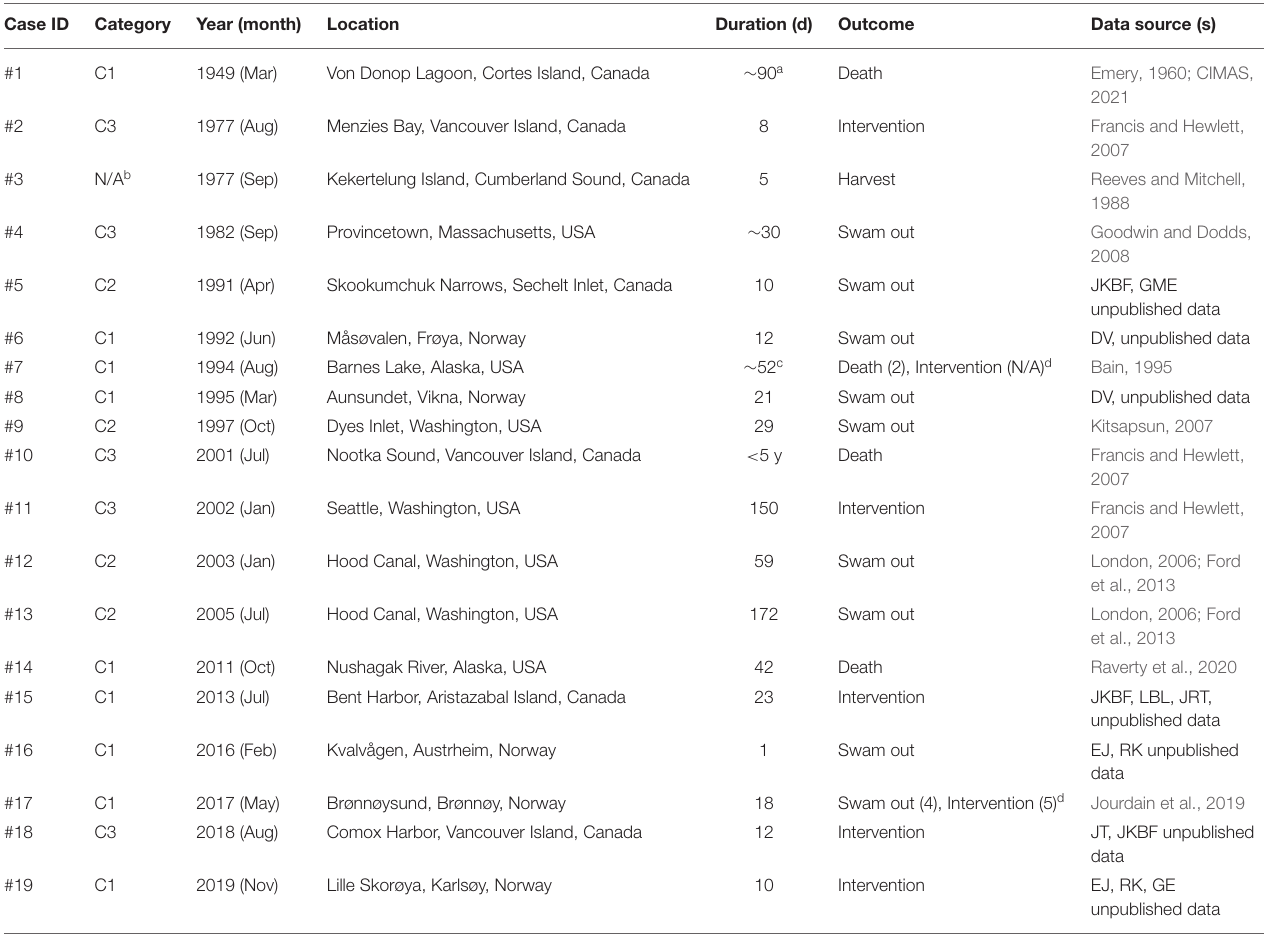
TABLE 1 | Summary of the 19 cases of natural killer whale entrapment 1949–2019, assigned categories (see Methods) and associated sources of information from which the data presented hereafter in the various sections of this study were derived. Case